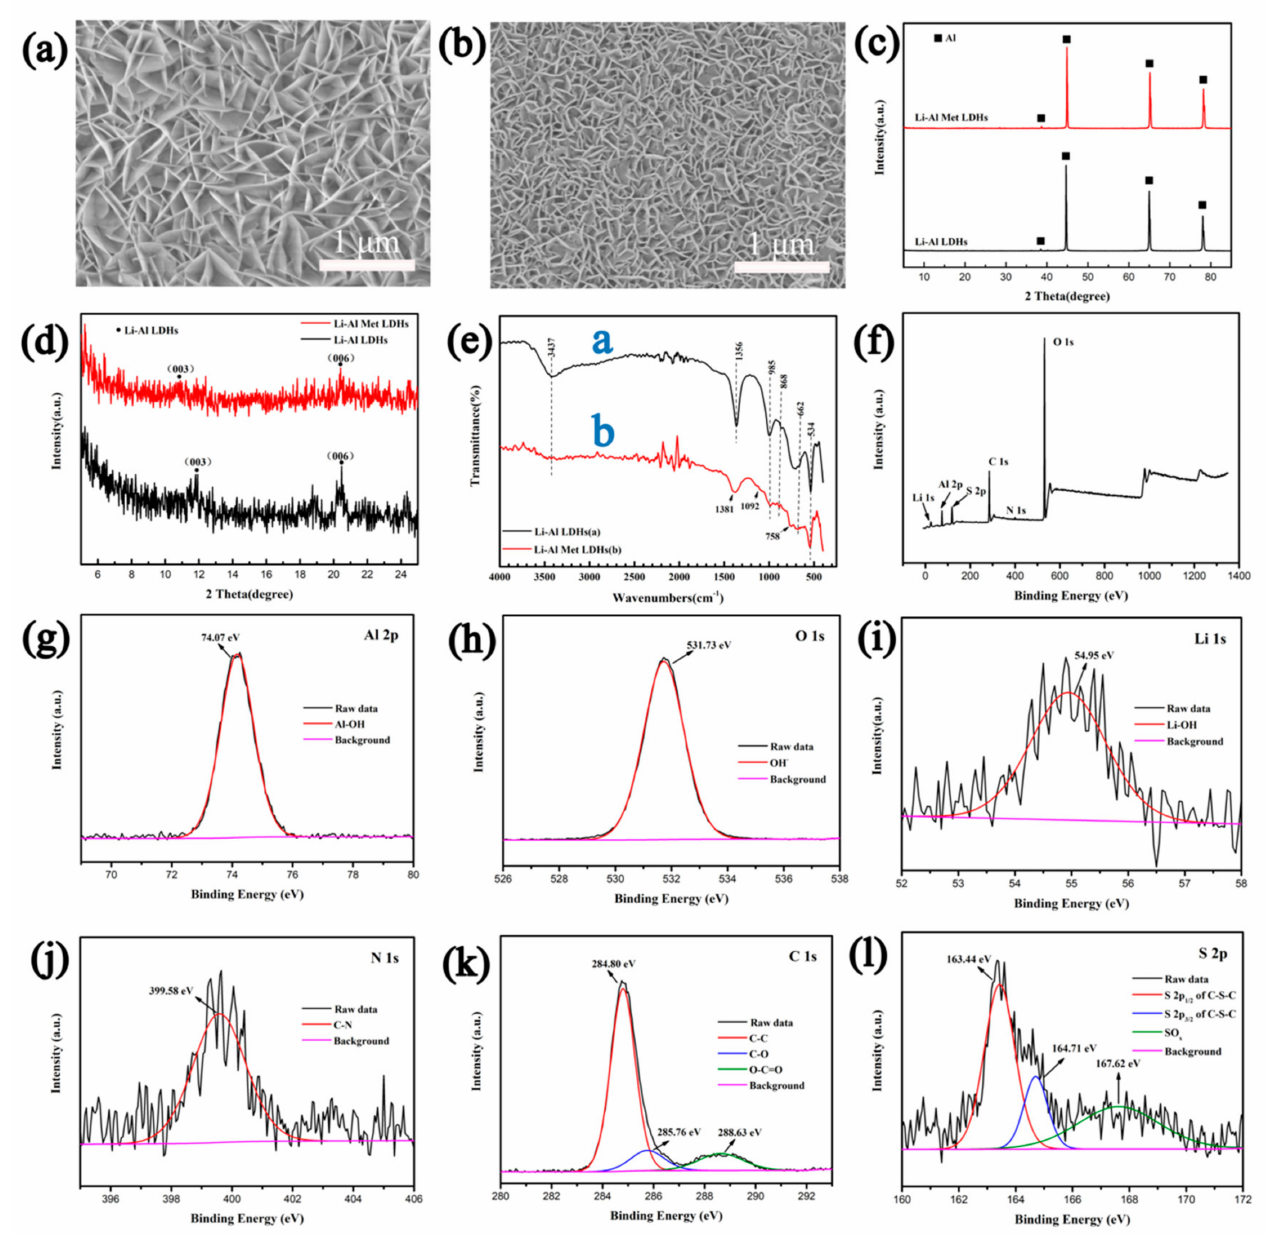
Figure 2. Surface morphology of NLDHs ( a ) and MLDHs ( b ); XRD patterns of NLDHs and MLDHs ( c ); magnifications of curves in ( c ) range from 5 ◦ to 25 ◦ ( d ); FTIR spectra of NLDHs and MLDHs ( e ), full XPS spectra of MLDHs ( f ) and high-resolution spectra of related elements ( g – l